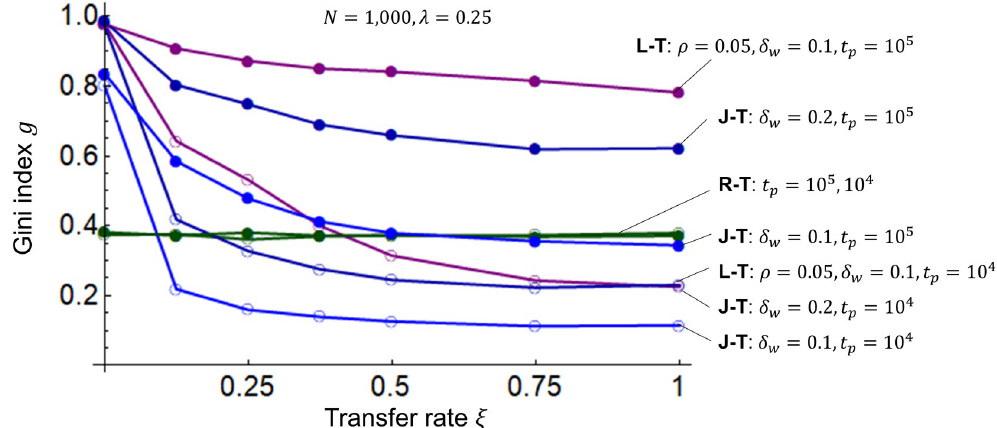
Fig 6. Gini indices for the R-T, L-T, and J-T models. The horizontal axis represents the transfer rate ξ , and the vertical axis represents the Gini index g . In the R-T, L-T, and J-T models, the number of agents is N = 1000, the initial values of wealth are m i (0) = 1 ( i = 1,2, ��� , N ), and the savings rate is λ = 0.25. The interest rate in the L-T model is ρ = 0.05, and the width of the profit/loss rate δ is δ = 0.1 The widths for the J-T model are δ = 0.1 and 0.2. The time periods for the transfers are t w w 10 4 and 10 5 .